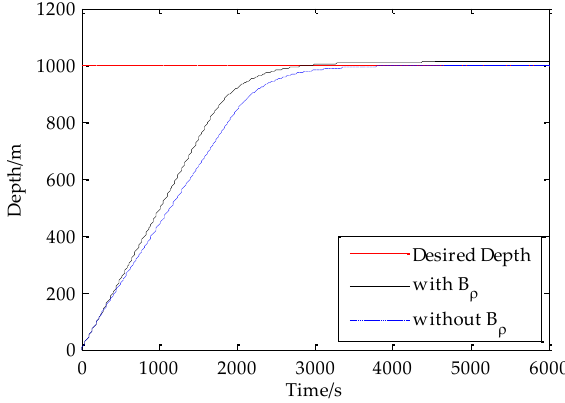
Figure 10. Depth response of PID depth controller.